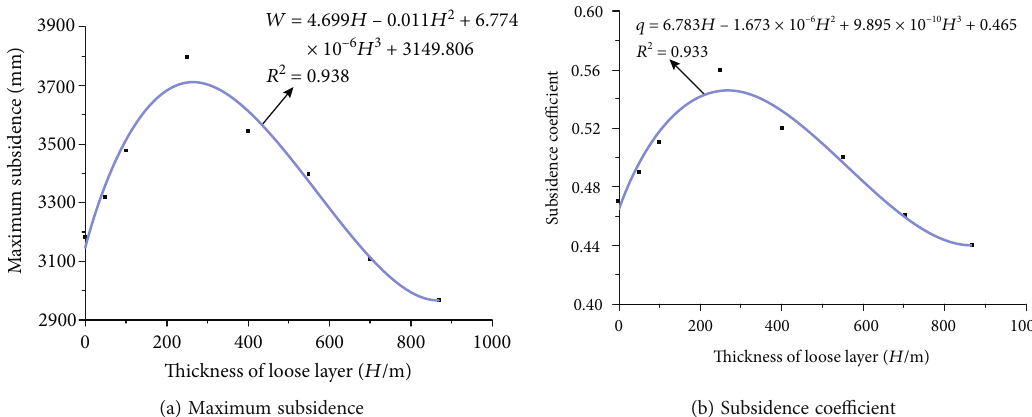
Figure 7: Fitting curve of maximum subsidence/subsidence coe ffi cient and thickness of loose layer.